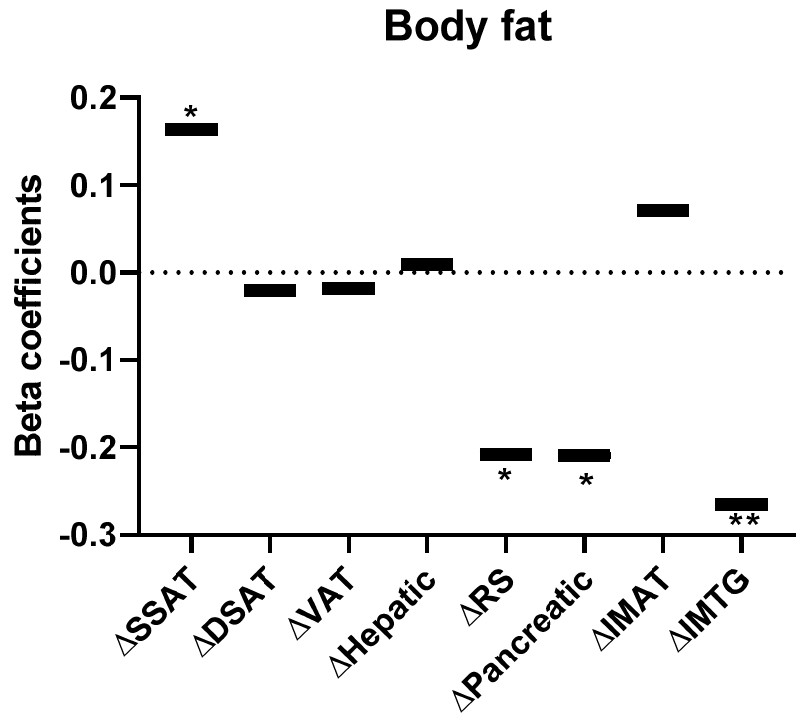
Figure 4. Association between body fat and 6 month changes in RQ (decreased/increased, n = 159). Multivariate linear regression model was used to assess the association between body fat and RQ changes (increased/decreased), adjusted for age, sex, diet group, baseline RQ, and changes in BMI. Standardized-Beta coefficients are presented for each variable. * p < 0.05; ** p < 0.01. Abbreviations: DSAT—deep subcutaneous adipose tissue; IMAT—intermuscular adipose tissue; IMTG intramuscu- lar triglycerides; RQ—respiratory quotient; RS—renal sinus; SSAT—superficial subcutaneous adipose tissue; VAT—Visceral adipose tissue.